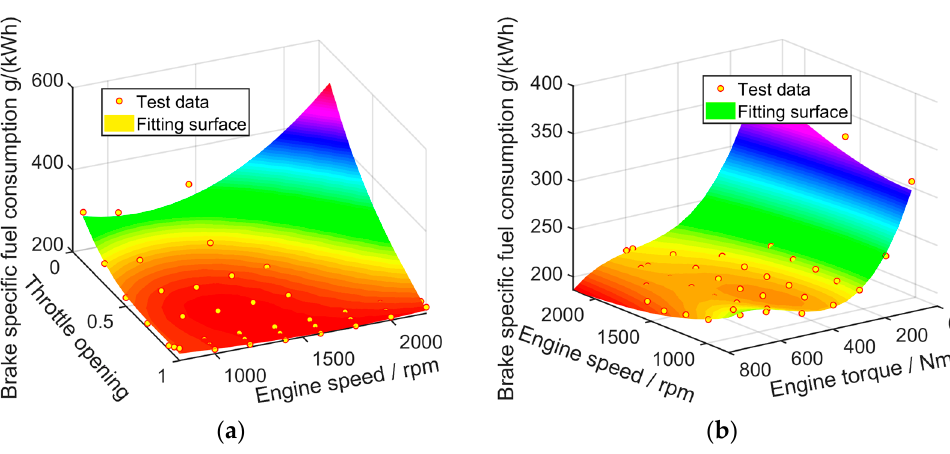
Figure 2. Engine fuel consumption model. ( a ) g e = f ( α , n ); ( b ) g e = f ( n , T ).